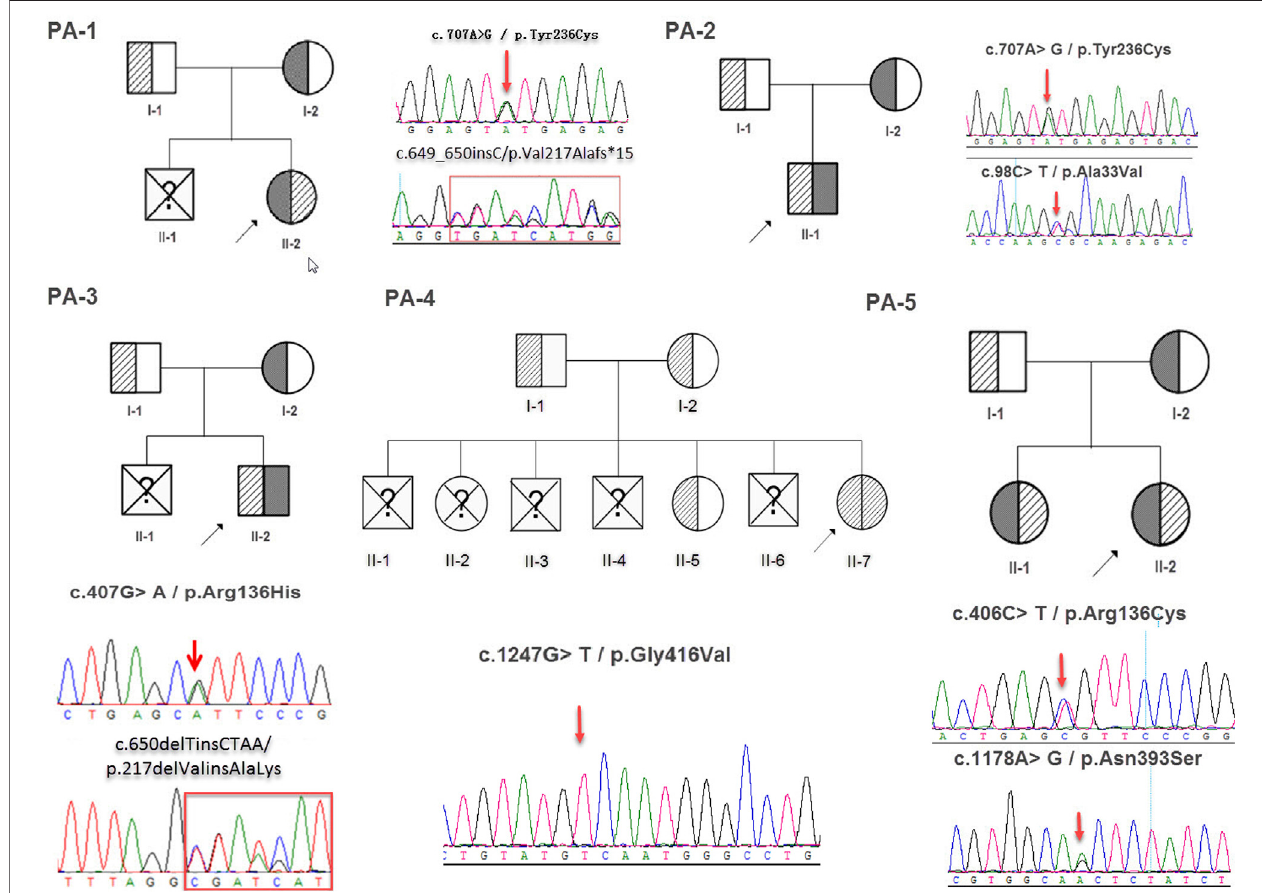
FIGURE 2 | The family tree and sanger sequencing